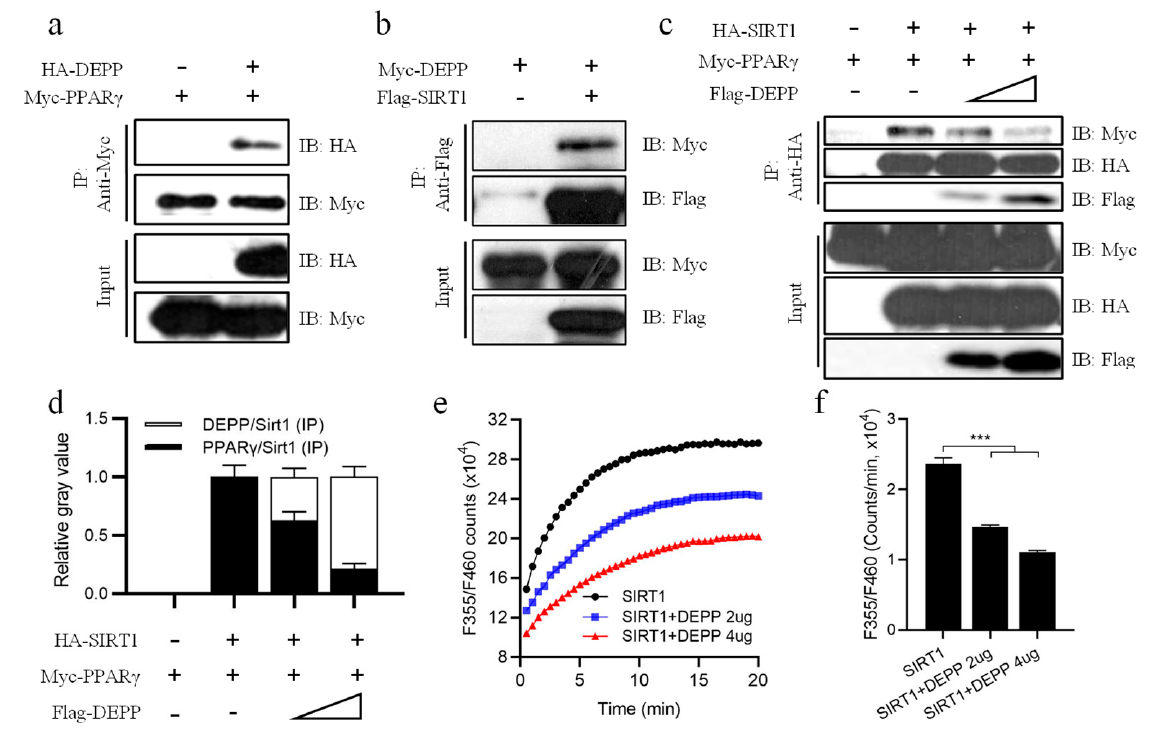
Figure 5. DEPP intercepted the interaction between SIRT1 and PPAR γ . ( a ) pCMV-HA-DEPP